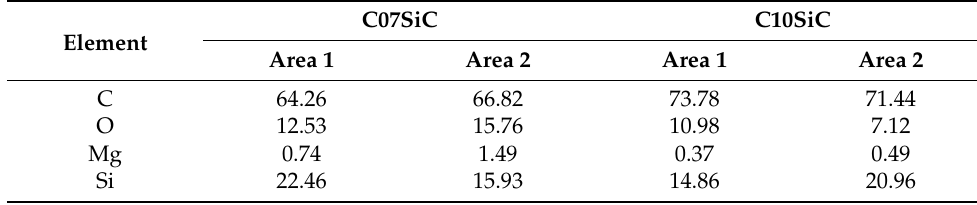
Table 8. Elemental composition of C07SiC and C10SiC